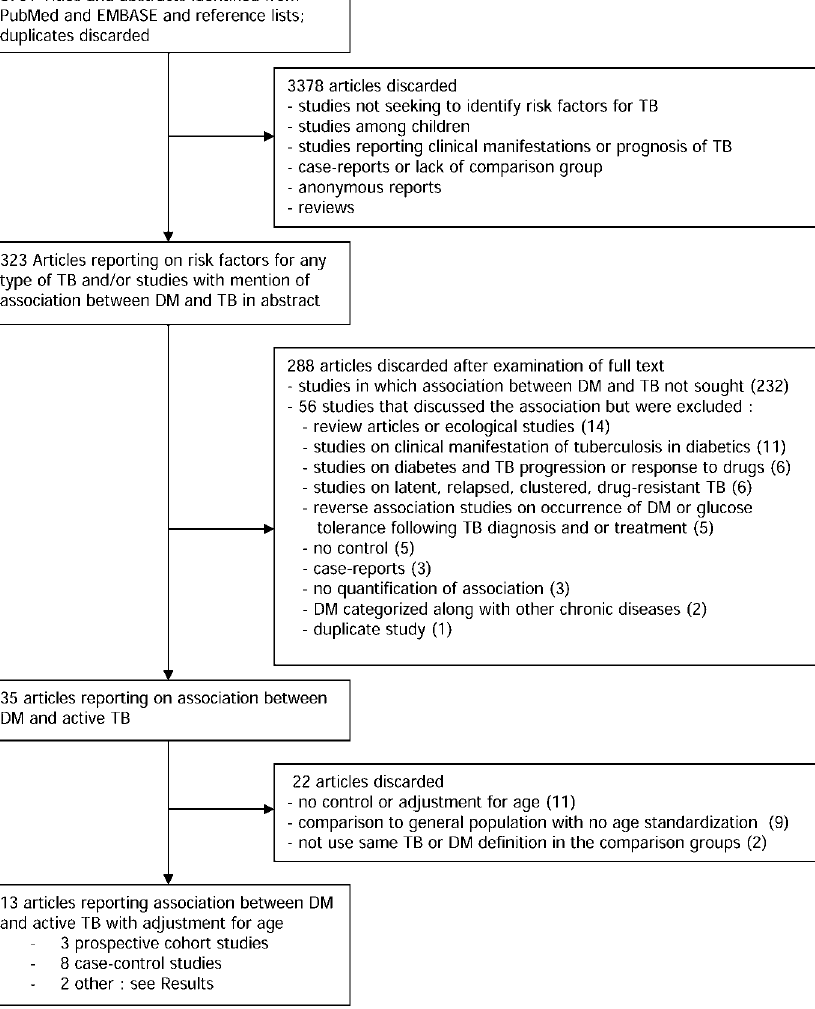
Figure 1. Flow Chart of Literature Search for Studies on the Association between Diabetes Mellitus and Active Tuberculosis